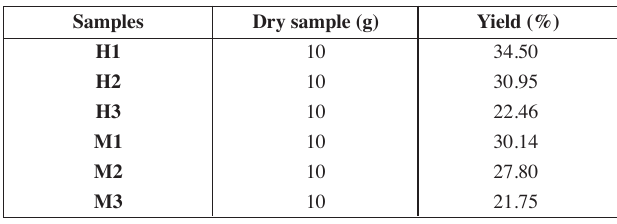
Tab. 1: The yields of pollen extract samples after extraction and freeze-